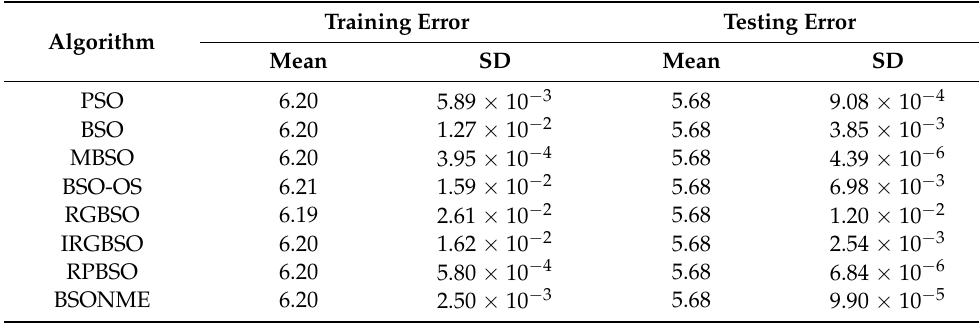
Table 16. Comparisons between PSO, BSO, MBSO, BSO-OS, RGBSO, IRGBSO, RPBSO, and BSONME on MSE of pipeline instantaneous water flow.